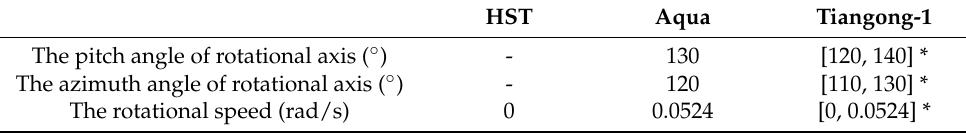
Figure 6. The 3D geometries and corresponding ground truth 3D point clouds of ( a , d ) HST, ( b , e ) Aqua, and ( c , f ) Tiangong-1. Table 1. The motion parameters of different